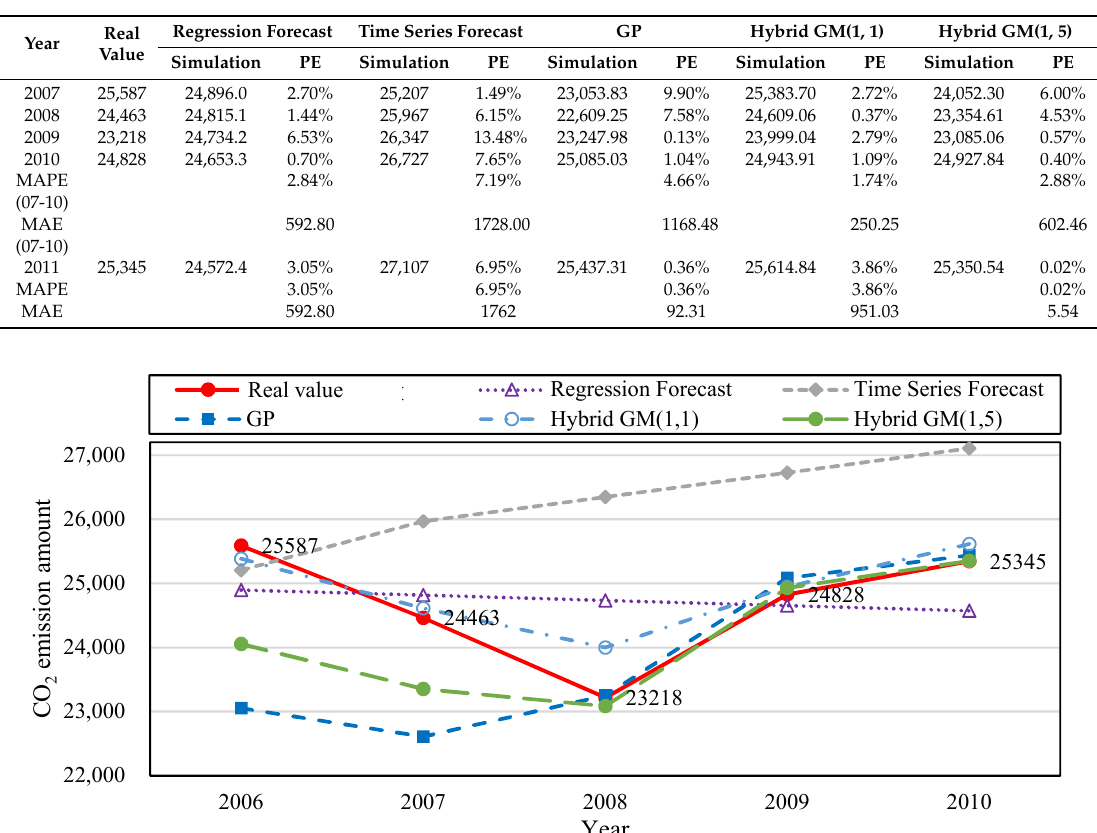
Figure 5. Comparison of PE values of the five forecast models trained with the data from 2007–2010 and tested with the data in 2011. 4.3. The Impact of Taiwan Businessmen Moving Overseas on Taiwan’s CO 2 Emission Amount When Taiwan began allowing Taiwan businessmen to invest in China in 1990, the first people to invest in China were from the manufacturing industry and labor-intensive industries. Investments in the manufacturing industry accounted for 90% of all investments in China. China is large and full of resources, so small and medium-size industries can achieve economies of scale in production and sales. In addition, the land, equipment, factory, and labor were cheap in China, which gave small and medium-size companies an advantage in growth. Considering the popularity of investing in China in recent years, we collected factors that impacted CO 2 emissions in Taiwan during the period that Taiwan businessmen were moving overseas. We collected data on population, GDP per capita, total energy consumption, number of registered motor vehicles, and amount invested in China for the period between 2010 and 2014. We then applied grey relational analysis to understand the importance of factors and the relational degree between factors. The key to the analysis is the relational degree between factors. The grey relational degrees of all factors was sorted from large to small. Table 10 shows that Taiwan’s energy consumption has the highest correlation with the amount of CO 2 emissions, followed by population, the number of registered motor vehicles, GDP per capita, and the amount invested in China.